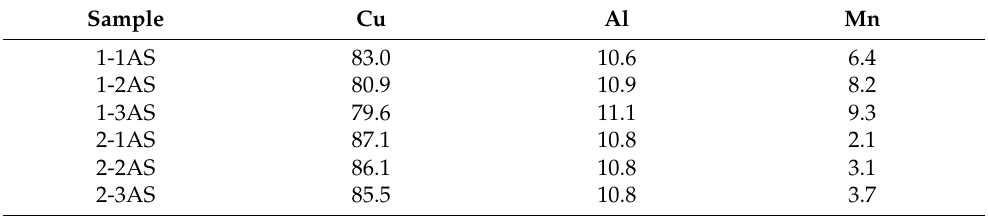
Table 3. EDX analysis data (wt.%).